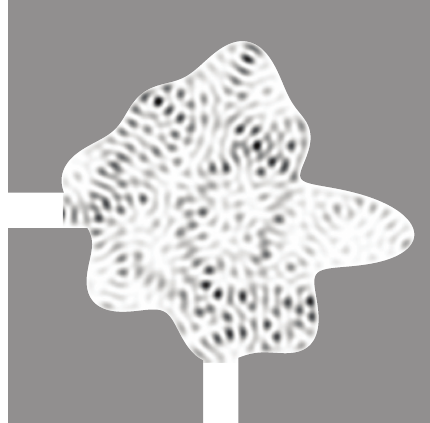
Figure 8: A contour plot of an electron density in a sample dot for √ 32 π , (cid:4) B = 4, and the fundamental mode Kd =